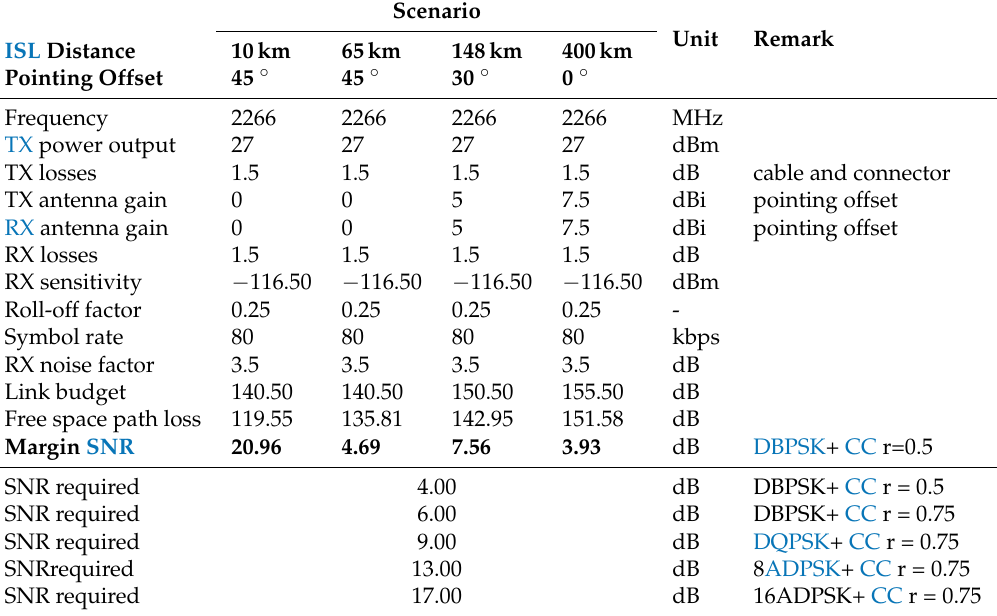
Table 10. Link budget of S-NET ISL for various distances and pointing